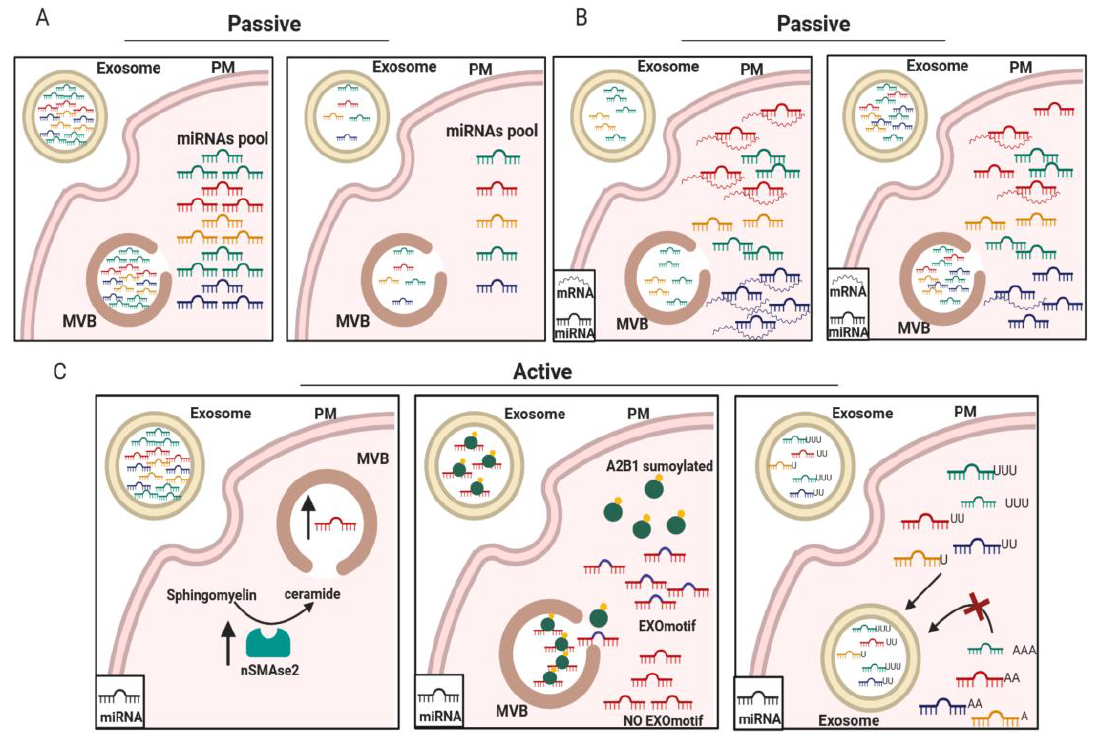
Figure 2. Active and passive mechanisms of miRNA loading in exosomes. miRNAs are more or less present in exosomes on the basis of either their relative abundance in cells ( A ) or the abundance of their target mRNAs ( B ). ( C ) Active mechanisms of miRNA loading are regulated by nSMAse2 (left panel) or by sumoylated A2B1, which recognizes an EXO motif present in the miRNA sequence (middle panel), or by a specific sequence containing uridine at the 3’UTR of the miRNA (right panel) . Pigati and colleagues also observed that some miRNAs, such as miR-451 and miR-1246, produced by cancer mammary cells are released independently from their intracellular levels, whereas the majority of the described miRNAs produced by non-malignant cells are retained in the